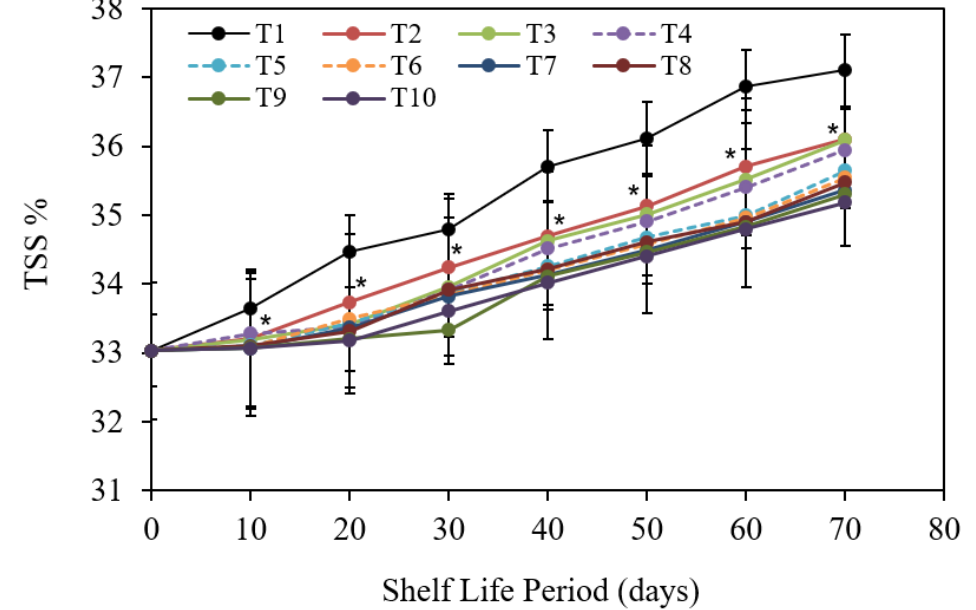
Figure 9. The impact of pre-harvest chitosan, chitosan nanoparticle and CaCl 2 foliar spray treatments on TSS of Barhi date fruits under cold storing for 70 d. Note that * sign denotes the significant differences between the control and edible coatings treatments, and T1, T2, T3, T4, T5, T6, T7, T8, T9, and T10 are water (control), 1 g/L chitosan, 2 g/L chitosan, 3 g/L chitosan, 1 g/L chitosan nanoparticles, 2 g/L chitosan nanoparticles, 3 g/L chitosan nanoparticles treatments, respectively.